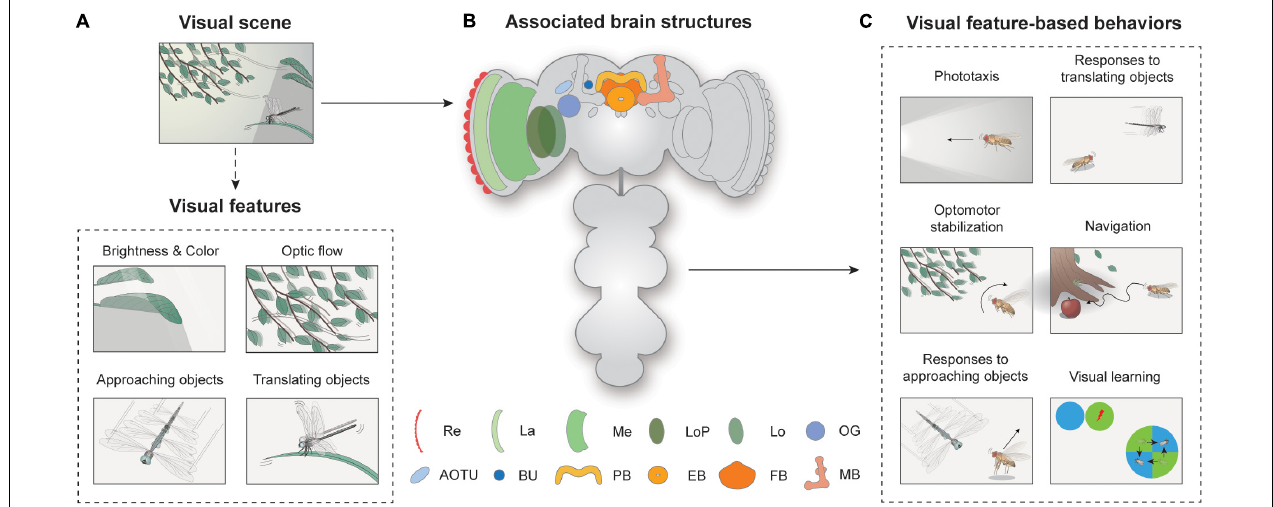
FIGURE 1 | Overview of visual feature-based behaviors and associated brain structures. (A) Spatiotemporal features in visual scenes may induce appropriate behavior in walking or flying Drosophila. A visual scene consists of visual features, such as brightness, color, optic flow, and approaching or translating objects. (B) Neural structures for visual feature-based behaviors. Re: retina, La: lamina, Me: medulla, LoP: lobula plate, Lo: lobula, OG: optic glomeruli, AOTU: anterior optic tubercle, BU: bulb, PB: protocerebral bridge, EB: ellipsoid body, FB: fan-shaped body, MB: mushroom body. (C) Flies exhibit various visual feature-driven behaviors, including phototaxis, optomotor stabilization, responses to moving objects, and navigation and visual